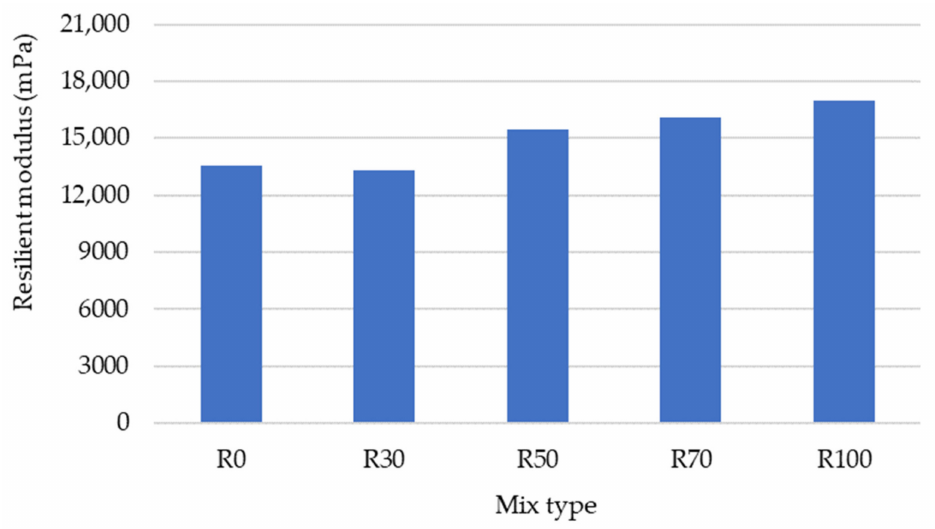
Figure 3. M R for the five